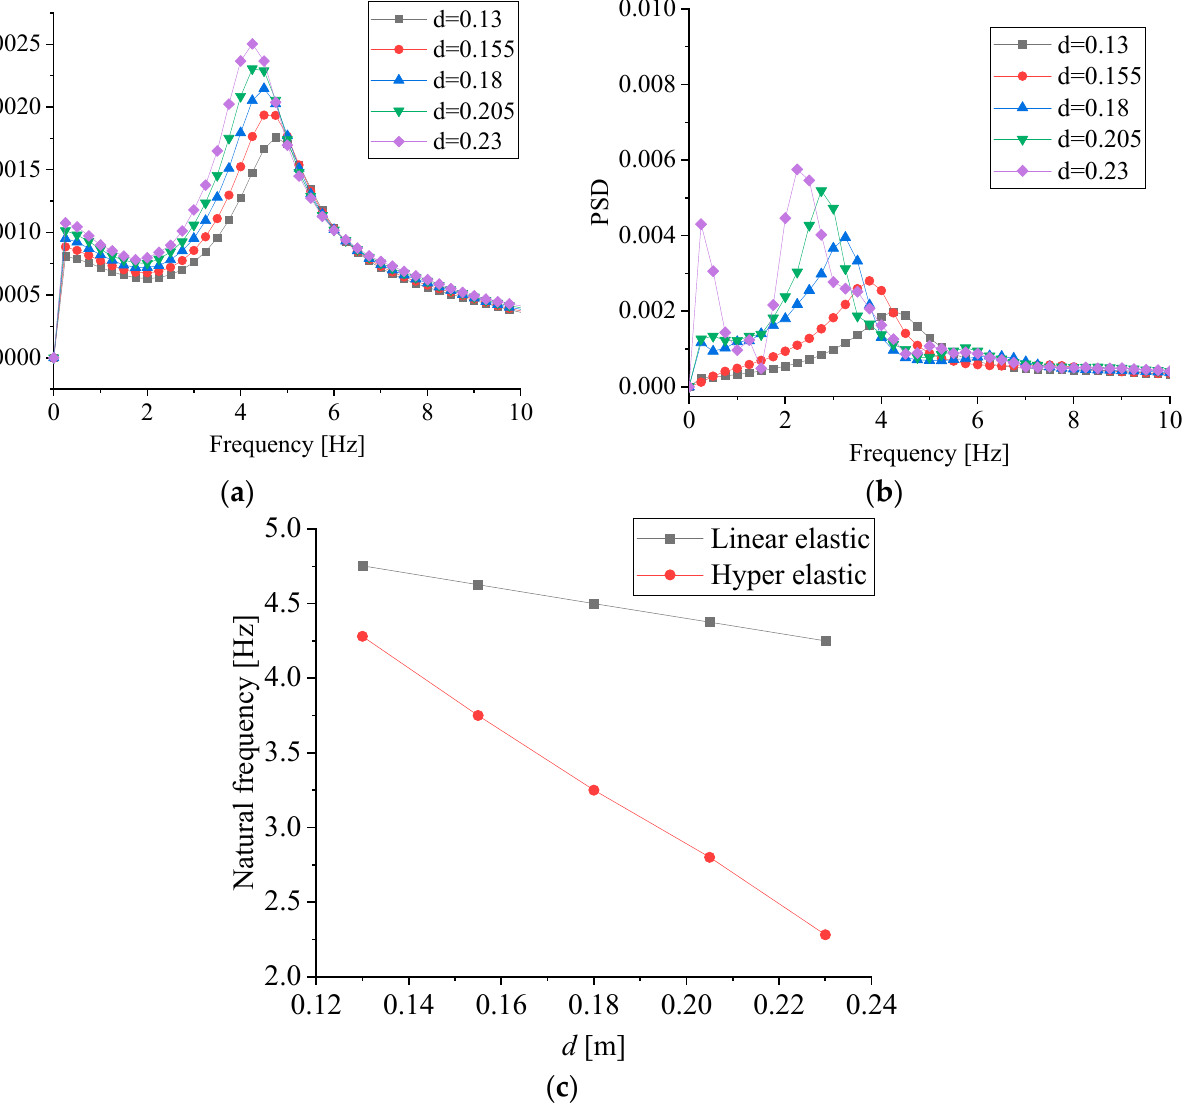
Figure 11. FFT analysis of the displacement with different d values for ( a ) linear-elastic material and ( b ) hyper-elastic material. ( c ) The natural frequencies via FFT analysis.